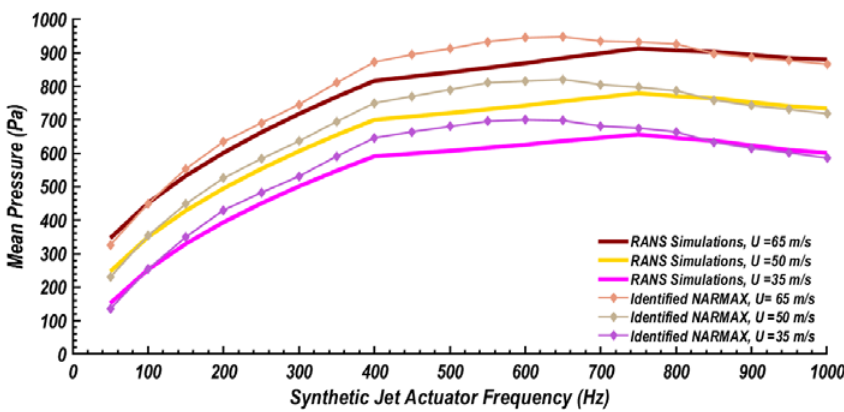
Figure 11. Comparison between NARMAX model and CFD results for the mean pressure and SJA frequency at AoA = 16°